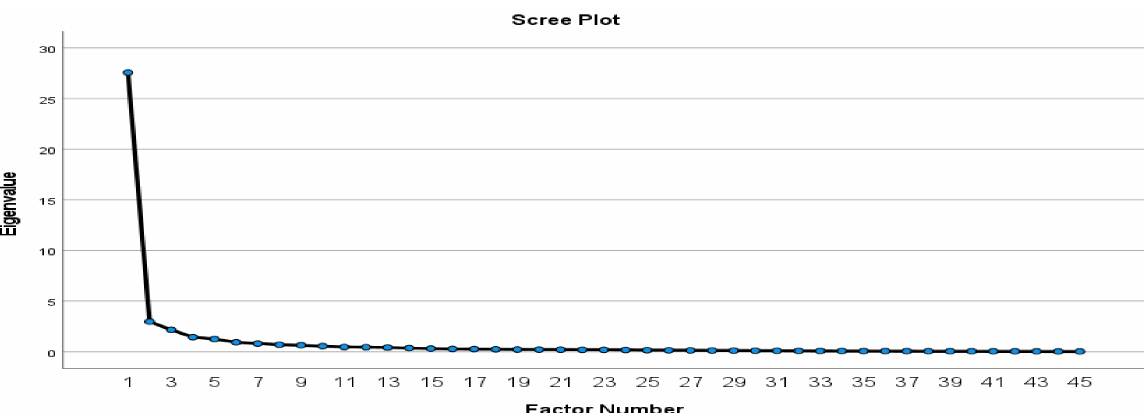
Figure 2. Scree plot for factors influencing construction health and safety agent collaboration.